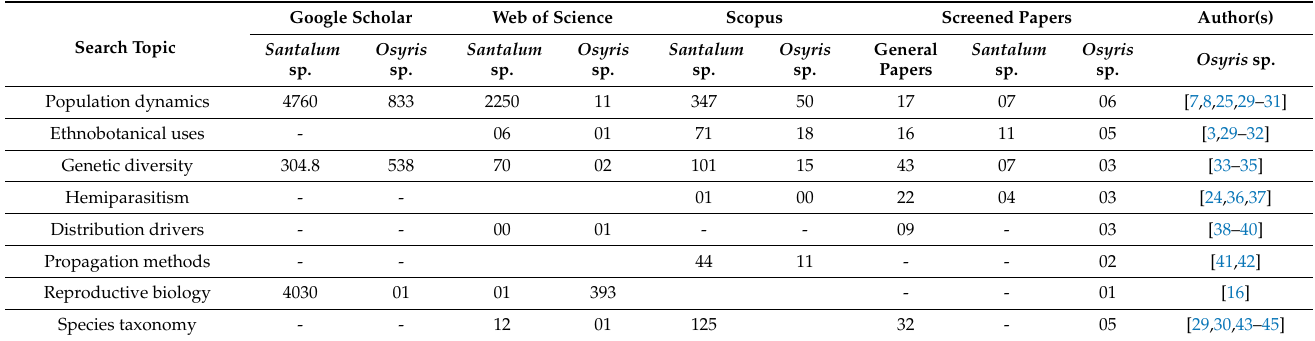
Table 1. Summary of search results on sandalwood